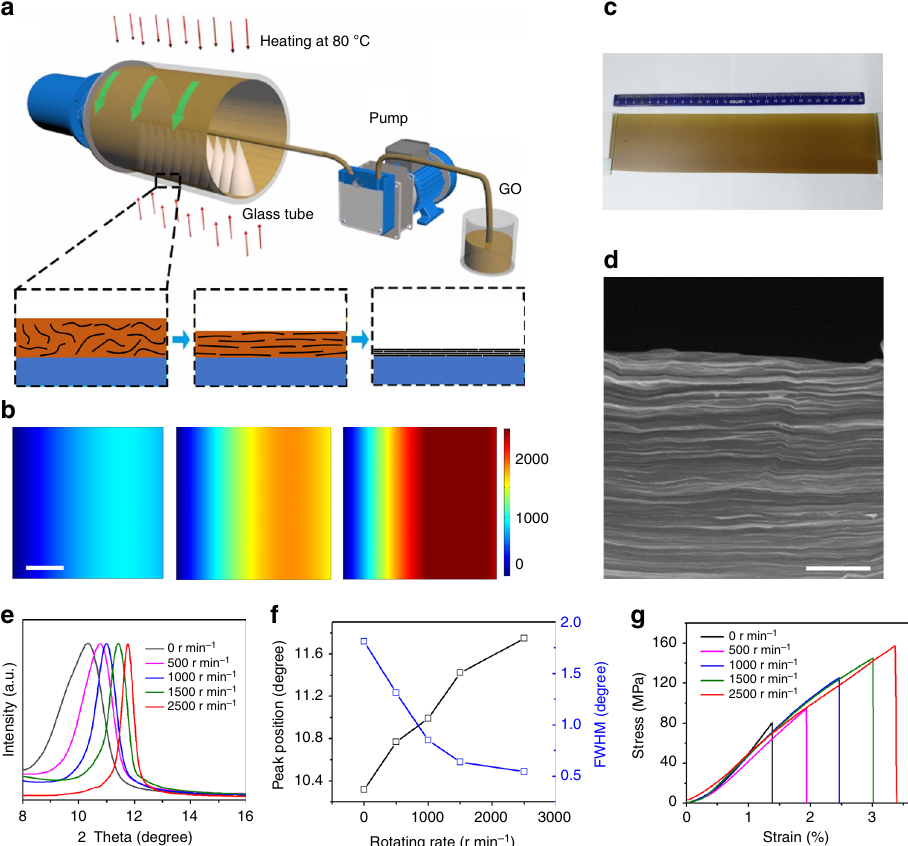
Fig. 1 Production and characterization of highly aligned and compact GO fi lms by CCC. a Schematic of the CCC production process. b Simulated transient shear rate fi eld at different rotating rate. Note that the viscosity of the liquid greatly increases during the CCC process because of the evaporation of water by low-temperature heating. Therefore, we used a viscosity of 10 Pa s in the simulations, which corresponds to the concentration of GO dispersion of ~22 mg mL – 1 . The horizontal axis from the right to the left represents the distance to the RHT wall, and the color bar shows the shear rate (s – 1 ). Left panel, 500 r min – 1 ; middle panel, 1000 r min – 1 ; right panel, 1500 r min – 1 . c A GO fi lm with a thickness of ~100 μ m and size of ~30 × 10 cm 2 . d Cross-sectional scanning electron microscopy (SEM) image of a GO fi lm, showing highly aligned and compact layered structure. e – g XRD patterns ( e ) the corresponding XRD peak position and full width at the half maximum (FWHM) ( f ), and stress-strain curves ( g ) of the GO fi lms produced with different rotating rate. Scale bars: b 50 μ m; d 1 μ e θ are the viscosity of the liquid and the angular velocity and tangent unit vector of the RHT, respectively. The centrifugal stress ( σ centrifugal ) is given by σ centrifugal = ρ g t g R 0 ω 2 e r , where ρ g , t g , R 0 , ω , and e r are the density and thickness of GO nanosheets and the inner radius, angular velocity and radial unit vector of the RHT, respectively. It is clear that the shear stress increases linearly with the rotating rate of RHT and the viscosity of the liquid, and the centrifugal stress increases with the rotating rate and diameter of RHT. It has been reported that a shear stress of ~20 Pa is suf fi cient to align the GO nanosheets 30 . We estimated the shear stress applied to GO nanosheets in the GO dispersion used (8 mg mL − 1 ), which has a viscosity of 1.26 Pa s. The shear stress obtained is ~66, 131, 197, and 329 Pa for the rotating rate of 500, 1000, 1500, and 2500 r min − 1 , respectively. Because of the fl ow is always in the region of laminar fl ow when the tube rotating rate is less than ~10 10 r min − 1 , it is expected that the alignment and compaction of GO fi lms can be improved by simply increasing the rotating rate from 0 to 2500 r min − 1 . Note that the real shear stress should be much larger for each case during CCC process, since the viscosity of the liquid is increased with the evaporation of water by heating. Therefore, good alignment and compaction can also be achieved by using GO dispersion with much smaller concentration as raw material.